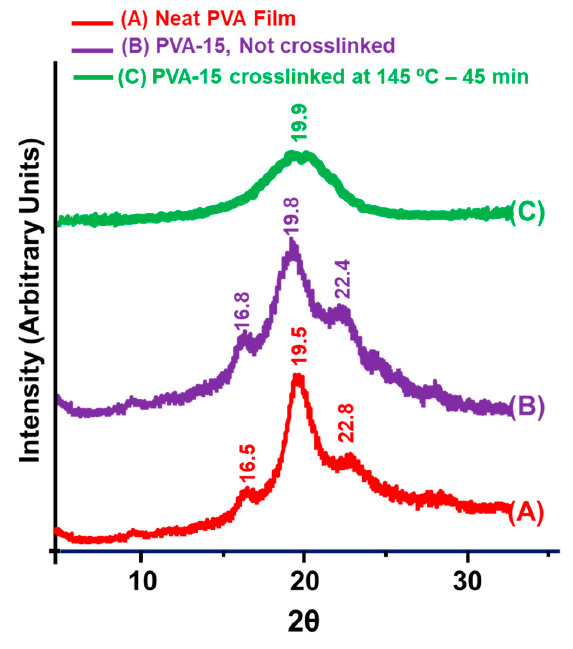
Figure 7. XRD analysis of the prepared NCFs.